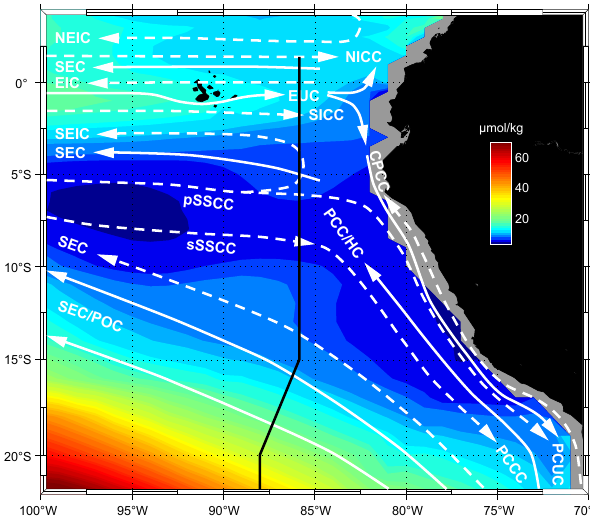
Figure 2. Oxygen concentration (µmolkg − 1 ) in the eastern trop- ical Pacific at σ θ = 26 . 8kg m − 3 (close to the deep oxygen min- imum) as obtained from the MIMOC climatology (Schmidtko et al., 2013) with circulation schematic superimposed. Current bands displayed are, for the surface layer (white solid arrows), the South Equatorial Current (SEC), the Equatorial Undercurrent (EUC), the Peru–Chile or Humboldt Current (PCC/HC), the Peru Oceanic Cur- rent (POC), and for the thermocline layer (white dashed arrows), the North Equatorial Intermediate Current (NEIC), the North Inter- mediate Countercurrent (NICC), the Equatorial Intermediate Cur- rent (EIC), the South Intermediate Countercurrent (SICC), the pri- mary and secondary Southern Subsurface countercurrents (pSSCC, sSSCC), the deeper layer of the SEC, the Chile–Peru Coastal Cur- rent (CPCC), the Peru–Chile Undercurrent (PCUC) and the Peru– Chile Countercurrent (PCCC). The location of the ∼ 86 ◦ W section is marked by the black line